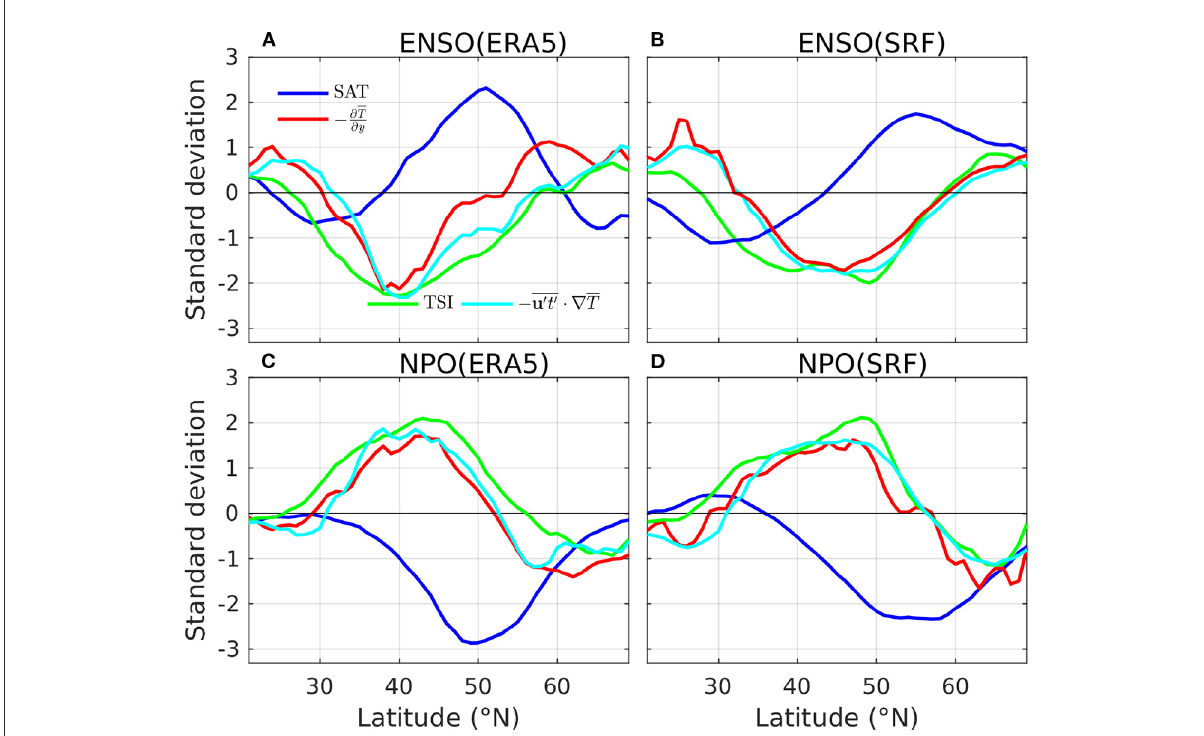
FIGURE6 The zonally averaged regression coefficients over 110 ◦ W − 70 ◦ W for the DJF SAT (blue), TSI (green), 850-hPa temperature gradient (red), and the advection term at 850 hPa (cyan) during 1992–2022. The regression onto the observed[[Inline Image]] NINO3.4 from (A) ERA5 reanalysis and (B) SPEAR’s SRF, and the observed NPO index from (C) ERA5 reanalysis and (D) SPEAR’s SRF. For plotting purpose, all the zonally averaged regression coefficients normalized by the corresponding spatial standard deviations over 20 ◦ N − 70 ◦